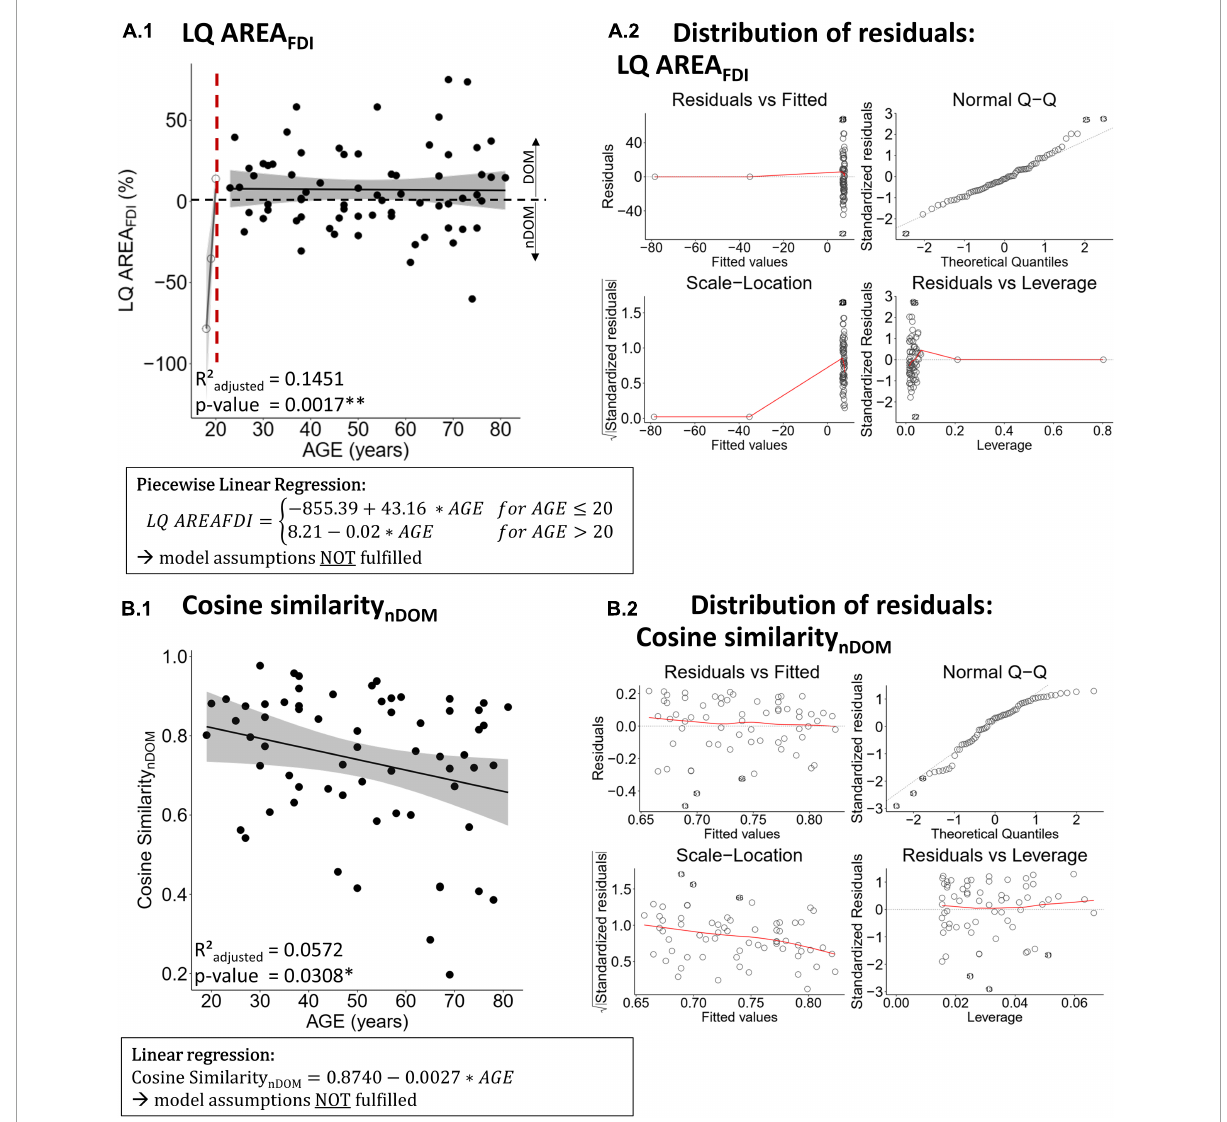
FIGURE2 Best regression fits for the lateralization quotient of the first dorsal interosseus (FDI) motor area [LQ AREA FDI , panel (A.1) ] and the cosine similarity between the FDI and abductor digiti minimi (ADM) representation of the non-dominant hemisphere [Cosine Similarity nDOM , panel (B.1) ]. Panel (A.2,B.2) show the distribution of the residuals, respectively, for LQ AREA FDI and Cosine Similarity nDOM regressions. Estimates of significant regression models are stated in a rectangle below the plot and the regression is indicated in the plot by a solid line. Ribbons depict the 95% confidence interval of the fit. Significant p-values are indicated with asterisks (** p < 0.01; * p < 0.05) and printed in